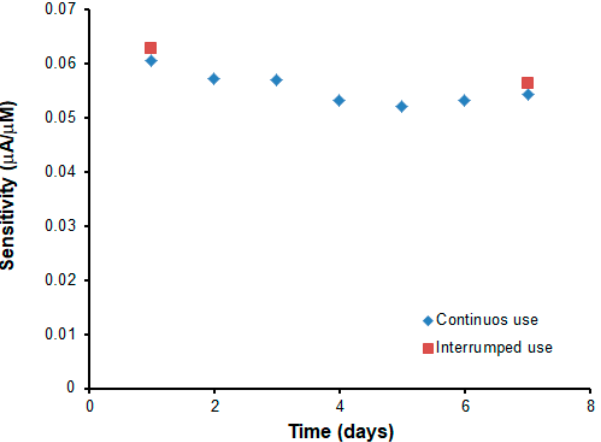
Figure 11. Evaluation of the storage stability of two PCA biosensors during one week by comparison of its sensitivity. When not in use, biosensors were stored at 4 °C.